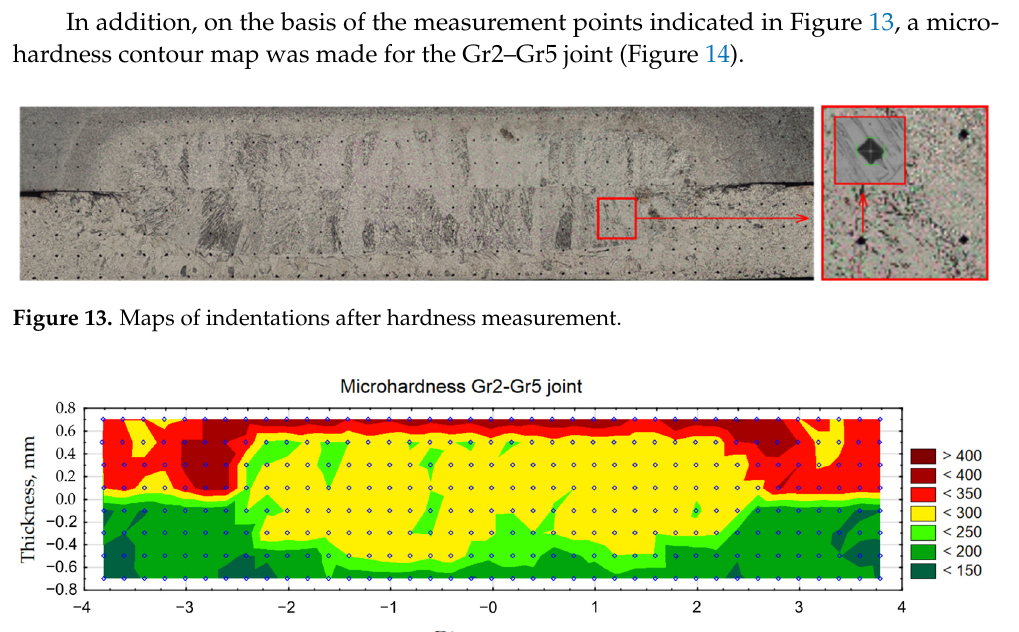
Figure 12. Microhardness of Gr2–Gr5 joints: ( a ) horizontal and vertical measurement lines; ( b ) horizontal hardness distributions and ( c ) vertical hardness distribution.